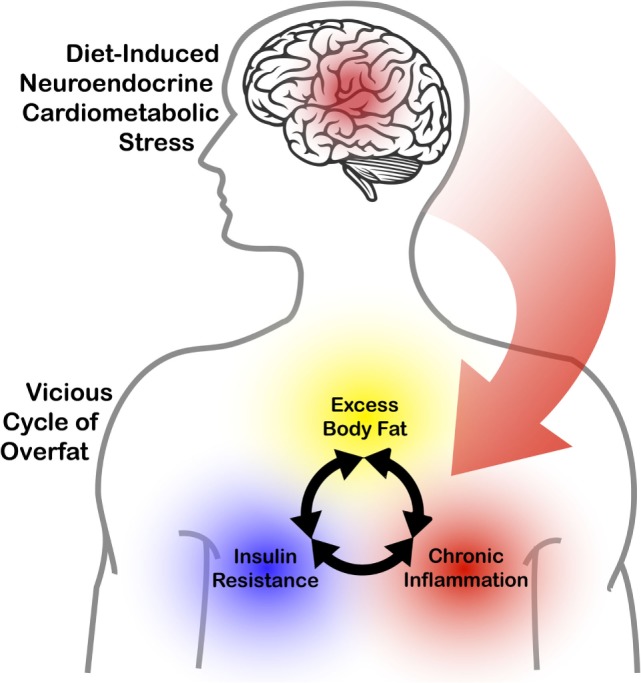
The impact of diet-induced neuroendocrine cardiometabolic stress on the interrelationship between excess body fat, chronic inflammation, and insulin resistance.